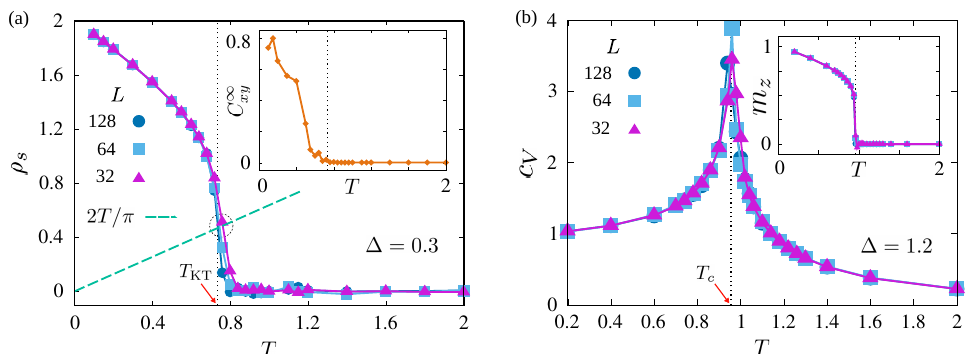
Figure 9: Kosterlitz-Thouless (KT) and Ising transitions: (a) The temperature dependence of spin stiffness ρ obtained from the intersection between ρ largest system size ( L = 128). Inset shows C ∞ function of temperature. (b) The specific heat c Ising transition temperature T from the magnetization m